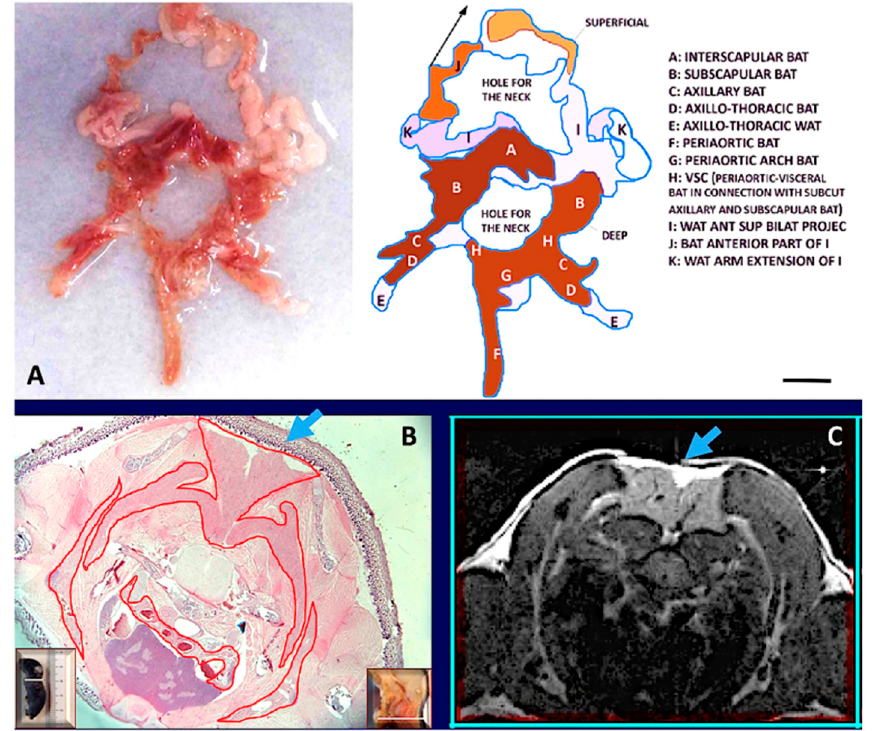
Figure 2. The fat neckerchief of mouse Adipose Organ. ( A ): Anatomical preparation of fat neckerchief displaying its continuity with peri ‐ aortic mediastinal fat (adult C57BL/6 at room temperature). The superficial white fat of the neckerchief is separated and folded up as indicated by the arrow in the diagram. ( B ): Histology (newborn, C57BL/6) and axial T1 ‐ weighted MRI image (adult, C57BL/6) (in ( C )) of the interscapular region, show the continuity between interscapular fat depot with the axillary fat, outlined by the red line surrounding brown fat in histology. Further evidence is shown by serial sections in histology and MRI (Supplementary Figure S7). The interscapular region (indicated by light blue arrows) also shows that brown (identified by a hypointense area) and white adipose tissue (hyperintense area) are contained in the same depot as also evident in anatomical preparations and histology. Insets in ( B ) show the plane of the section in the whole animal (left) and in its sagittal section (right). Bar: 10 mm in ( A , B ), and 1.5 mm in ( C ).